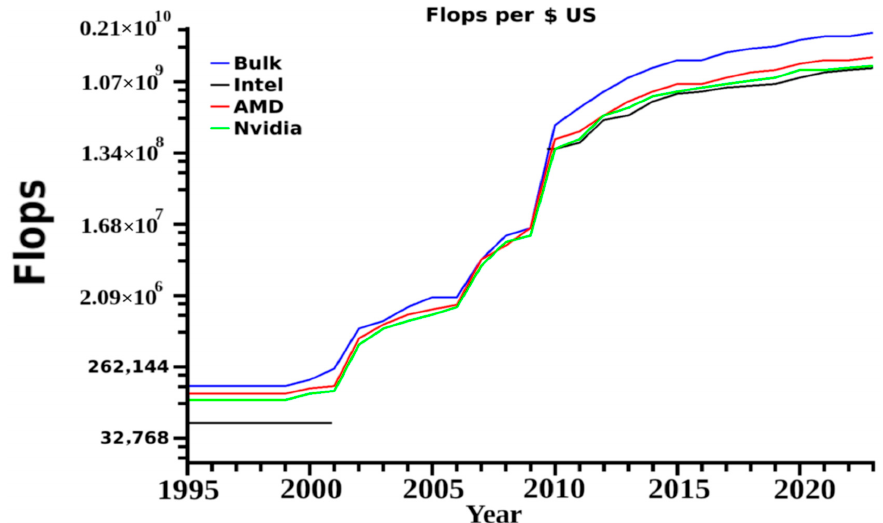
Figure 5. Number of flops per United States dollar by year. Almost mirroring the change in computer speed observed with GPU usage, the price per flop in computing power has decreased almost exponentially since early 2000. A recent plateau was observed around 2016, which is related to the limits of size in transistors. Intel (black) sold GPU’s primarily as PCI devices necessary to attach monitors from 1990–2000. In 2010, they began selling GPUs equivalent to Nvidia (green) and AMD (red). Currently Nvidia has exclusive purchase contracts with EU and US academic institutions, the US military as sole hardware supplier and Intel with the Chinese government and academia. This has prompted AMD to have lower prices in an attempt to sell GPU devices to the general public. Bulk (blue) are applicable to prices for all three companies when larger quantities of devices are purchased. A current standard GPU has a 20 teraflop (Nvidia, Intel) and 40 teraflop (AMD) processing capacity per single